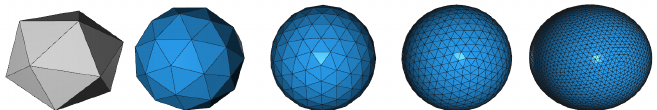
Figure 9. Approximation of the unit sphere with an icosahedron. The level 0 icosahedron is shown on the left with increasing refinements to the right. Triangle cells become buckets of a histogram on